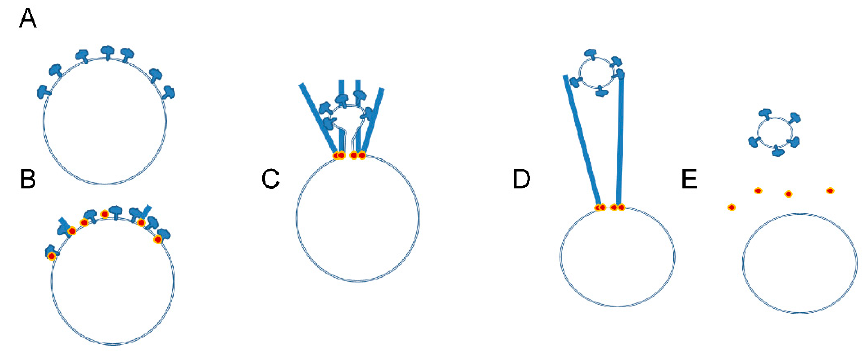
Figure 5. Model suggesting how V-ATPase binding to microfilaments can sort V-ATPase into a vesicle; ( A , B ) Arp2/3 complex or formin (shown as orange dot) is recruited to a vesicle at a site near V-ATPases and is activated to initiate actin polymerization with actin monomer adding on near the membrane, which is characteristic of actin polymerization in cells; ( C ) V-ATPase binds tightly to the actin filament at a specific location. As the actin filament elongates, the V-ATPase and associated membrane are drawn away from the vesicle membrane; ( D ) Eventually, the membrane tether breaks or is actively broken; ( E ) This leaves a mother vesicle depleted in V-ATPase and a daughter vesicle enriched in V-ATPase. This model is adapted from that of Carnell and colleagues [52]. The same basic mechanism could account for the internalization of V-ATPase from the ruffled plasma membrane.